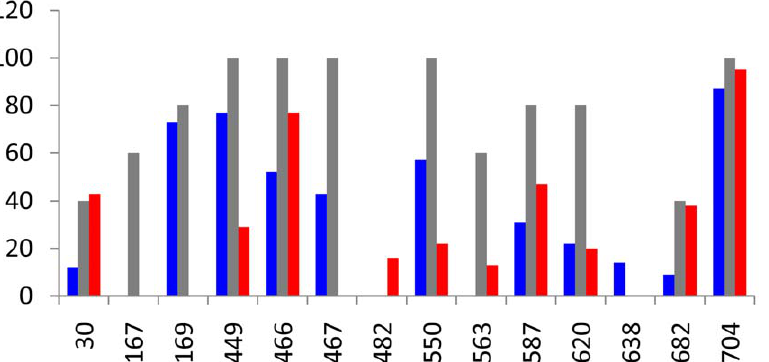
Figure 1. Effect of nearest neighbor mutations on cox2 mRNA editing. The editing efficiency of different editing sites on cox2 mRNAs was analyzed for 2 1 (blue bars) and + 1 (red bars) mutants from wheat cox2 constructs. Gray bars represent the editing status of wild type transcripts. Editing status of C targets was assessed by sequencing of at least 16 independent RT-PCR clones. The results presented are representative from at least two separate experiments. Editing efficiency variations in replicates was lower than 10%.